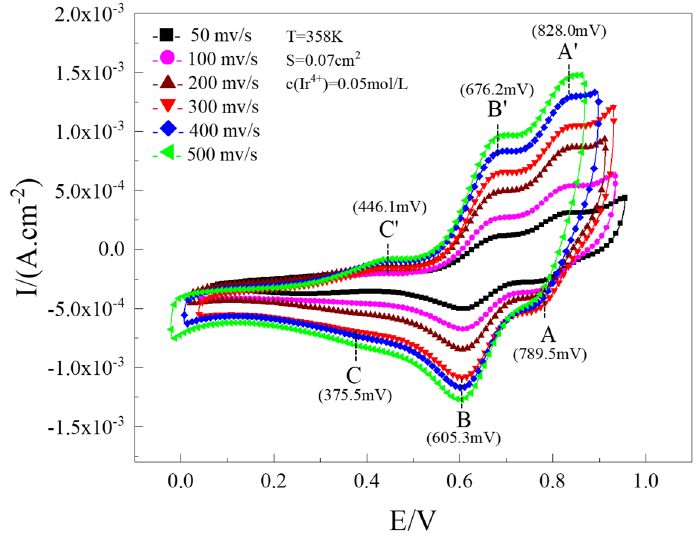
Figure 1. CV curves on the Pt cathode at different scan rates in iridium chloride ( Ⅳ ) so- lution.